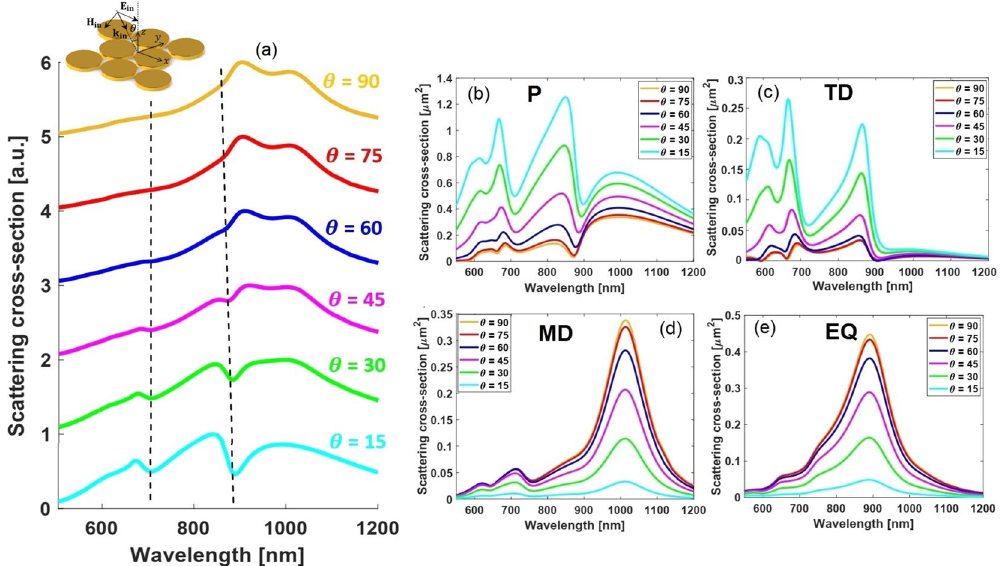
Figure 4. ( a ) Scattering spectra of the proposed oligomer ( R = 84 nm , g = 12nm , h = 20nm ) as the incident angle increases from 0 to 90 with an increment of 15. Evolution of the ( b ) electric dipole P ( c ) toroidal dipole TD ( d ) magnetic dipole MD, and ( e ) electric quadrupole EQ modes with the incident direction is included to distinguish the dominant resonance in each incident